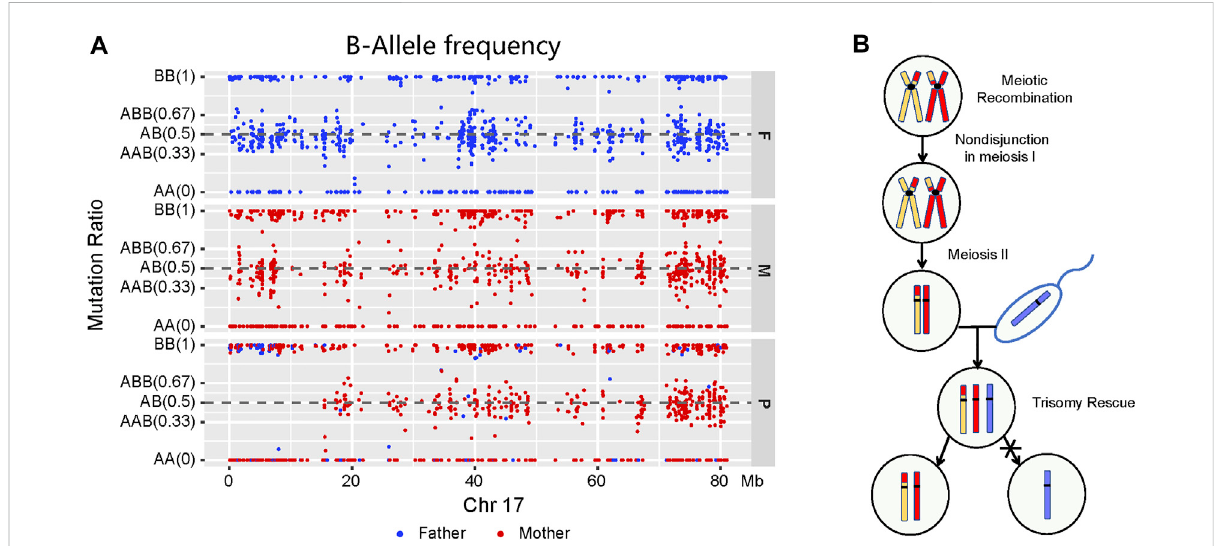
FIGURE 2 Molecular characterization and a model for the origin of mixUPD. (A) A loss of LOH region in the short arm of chromosome 17 described by B-allele frequency plot. Paternal and maternal sitesare highlightedinblueand red, respectively. A point isclassi fi edas AA — iftheBAF value is < 0.1,as AB/AAB/ABB — ifitisbetween0.1and0.9,andasBBifitis > 0.9.LOHtakesplace ontheshortarmofchromosome17(p11.2 – p13.3)inthepatient,and most points are generated maternally. (B) Schematic illustration of genetic events with mixUPD of chromosome 17.